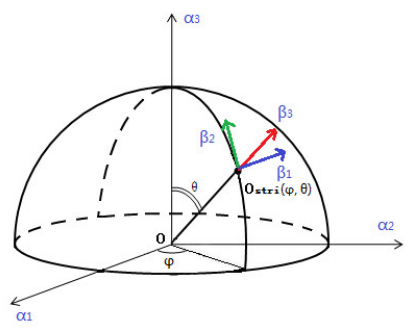
Figure 8. α and β coordinate systems.